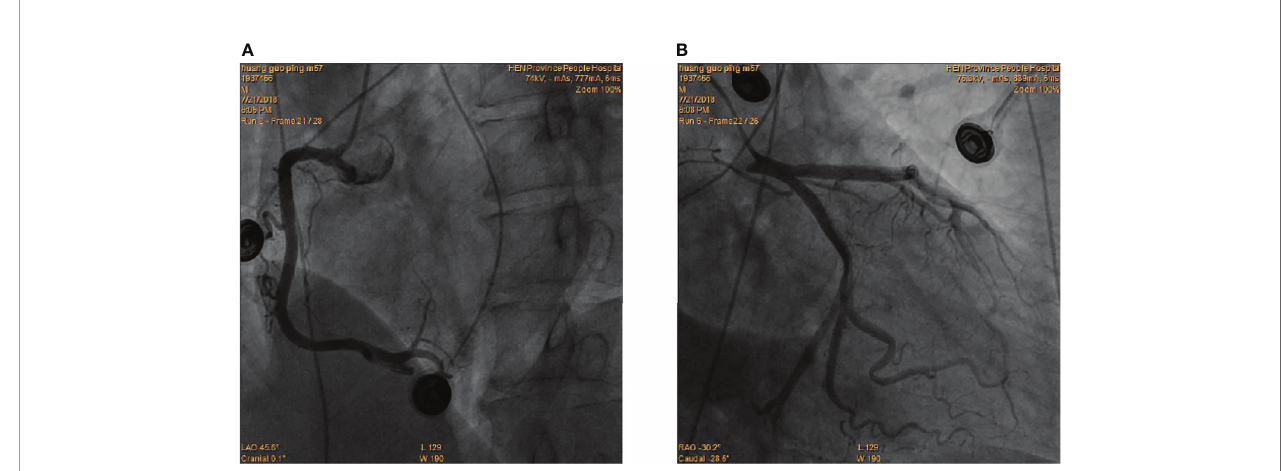
FIGURE 2 | Coronary angiography showed the absence of obstructive coronary lesions in RCA (A) , LAD and LCX (B)